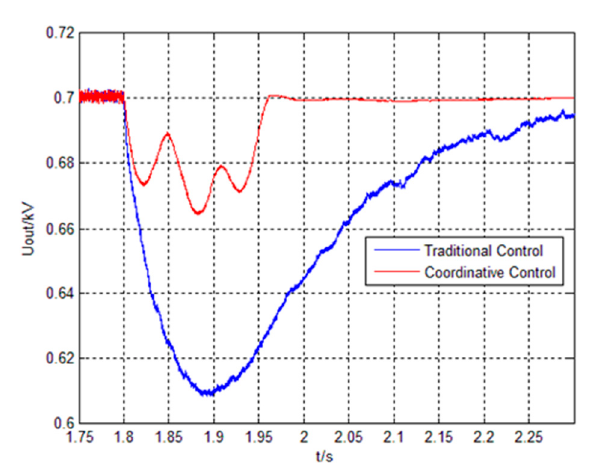
Figure 16. The comparison of voltage response during the island switching process.